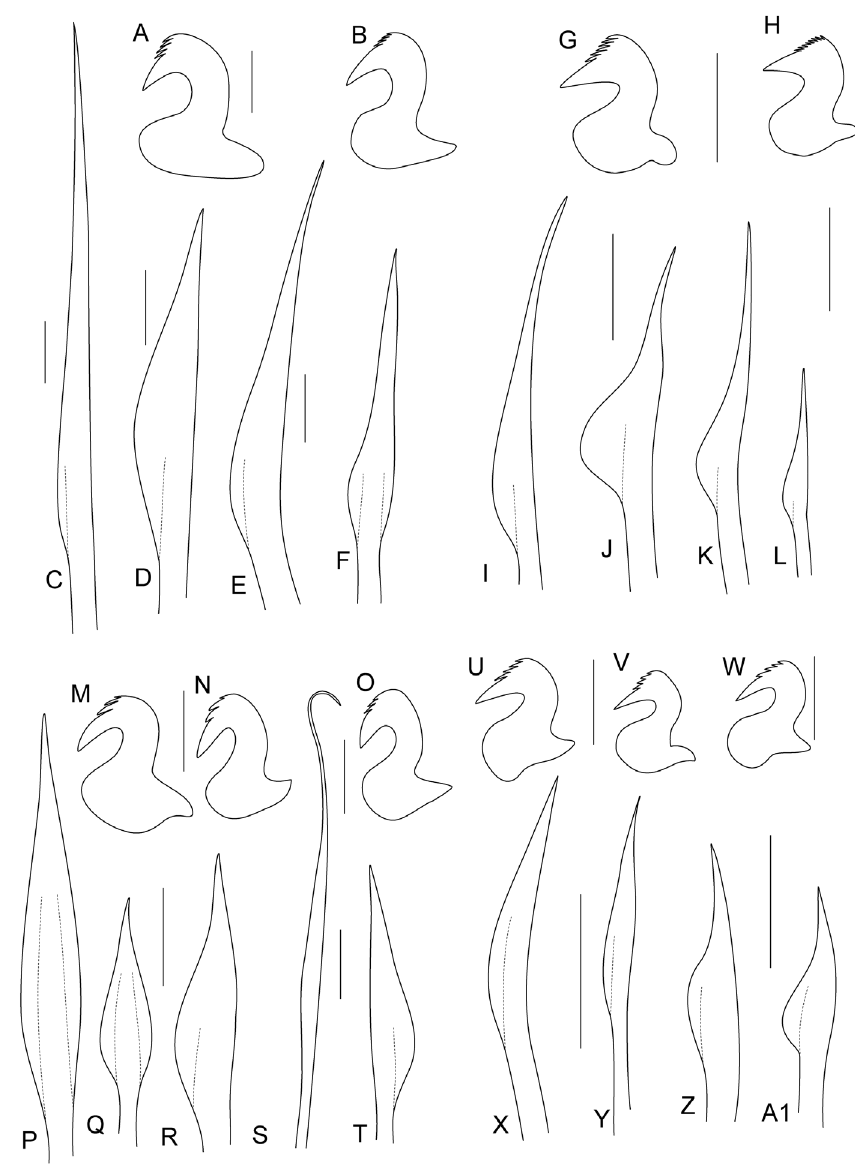
Figure 3. Line drawings of chaetae and uncini of Pseudobranchiomma species in Australia; A – F Pseu- dobranchiomma cf. P. emersoni G – L Pseudobranchiomma cf. P. orientalis M–T Pseudobranchiomma pallida sp. n. U – Z, A1 Pseudobranchiomma cf. P. schizogenica ; A Thoracic uncinus B Abdominal uncinus C Su- perior thoracic chaeta D Inferior thoracic chaeta E, F Inferior abdominal chaetae G Thoracic